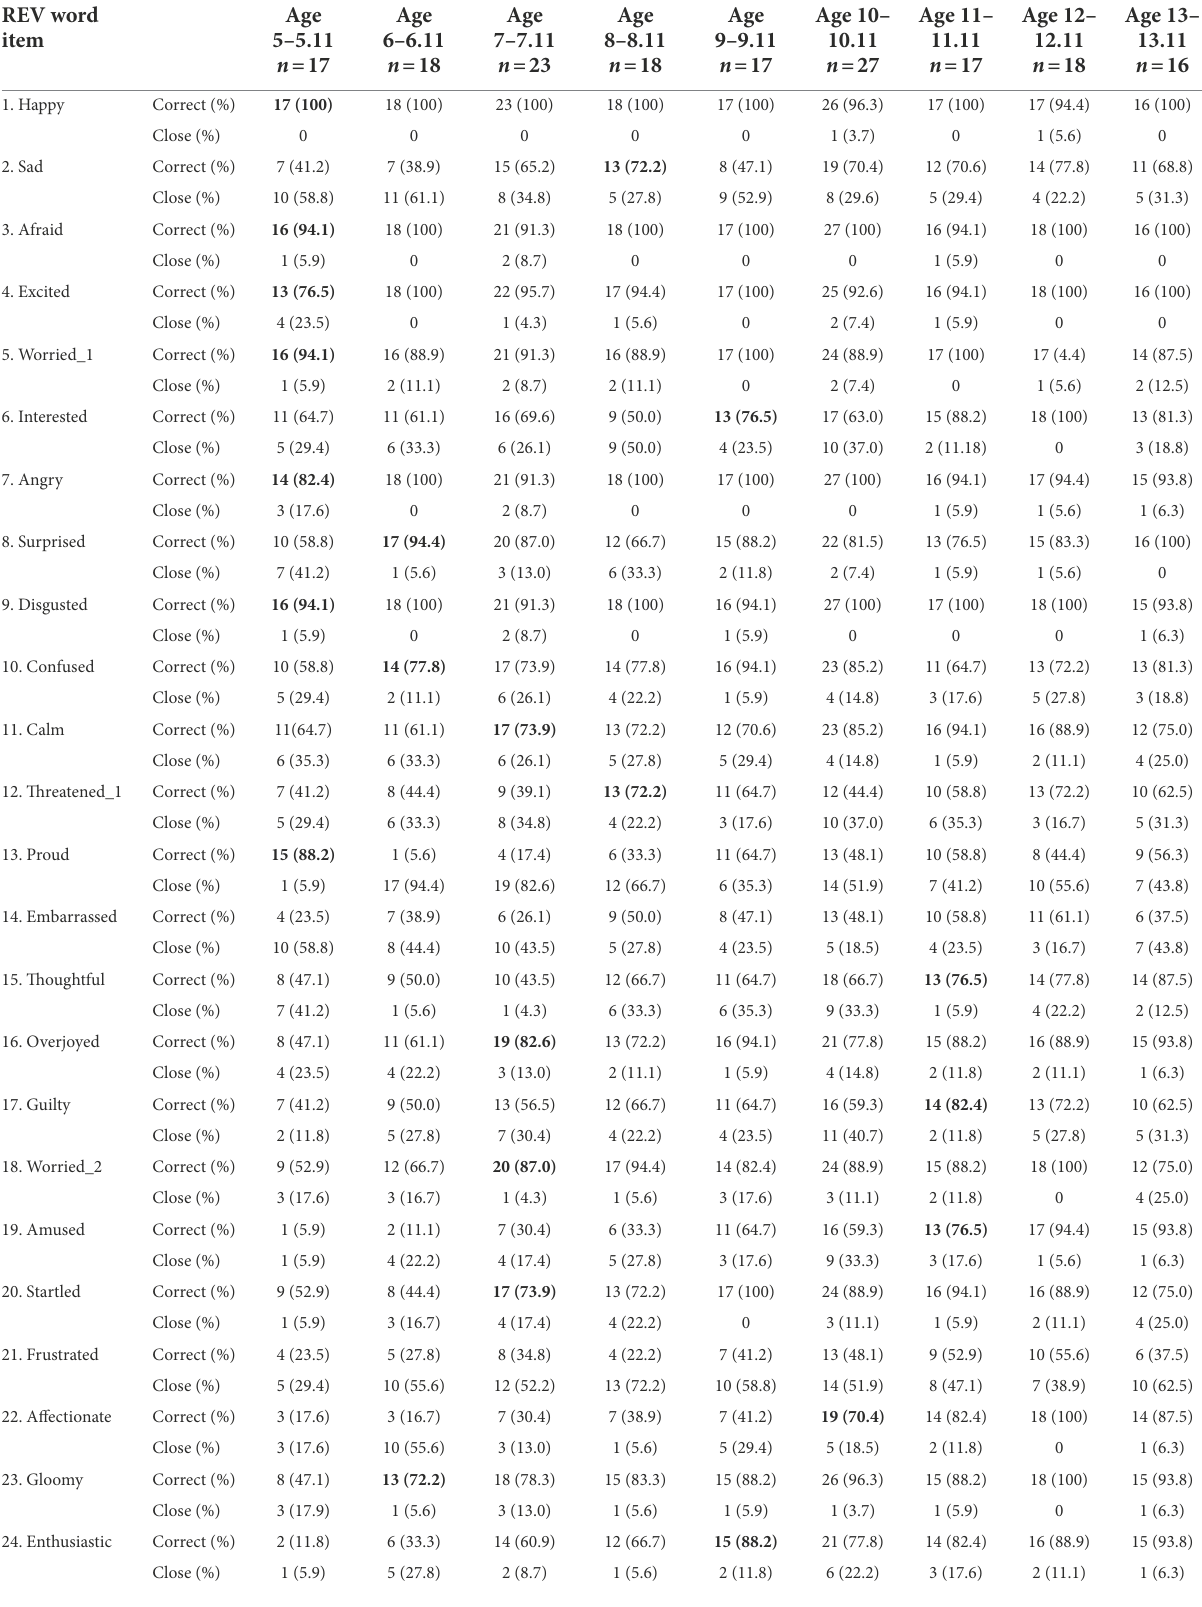
TABLE 3 Showing REV responses organized by word item and